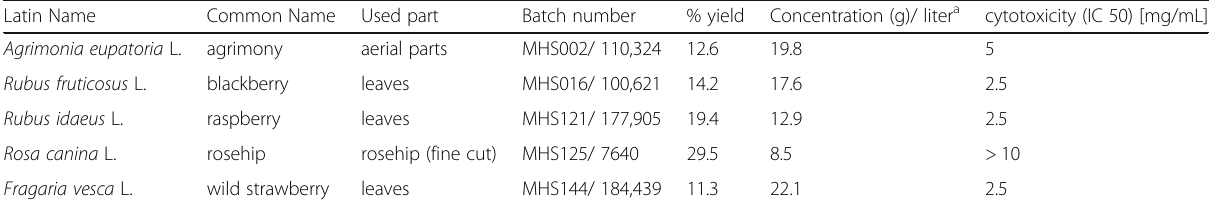
Table 3 Yields of prepared plant